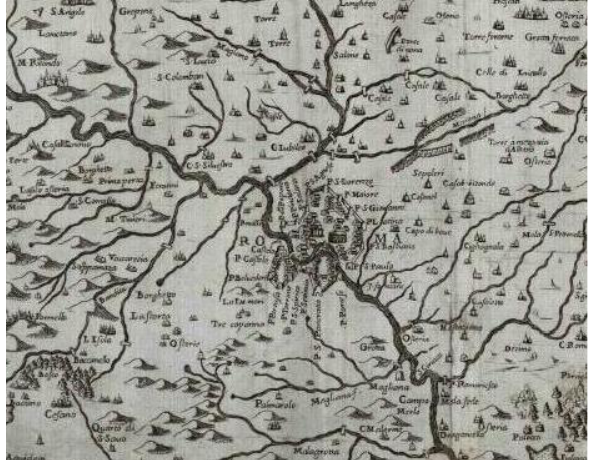
Figure 4. Planimetric excerpt by Paolo Forlani, 1563.